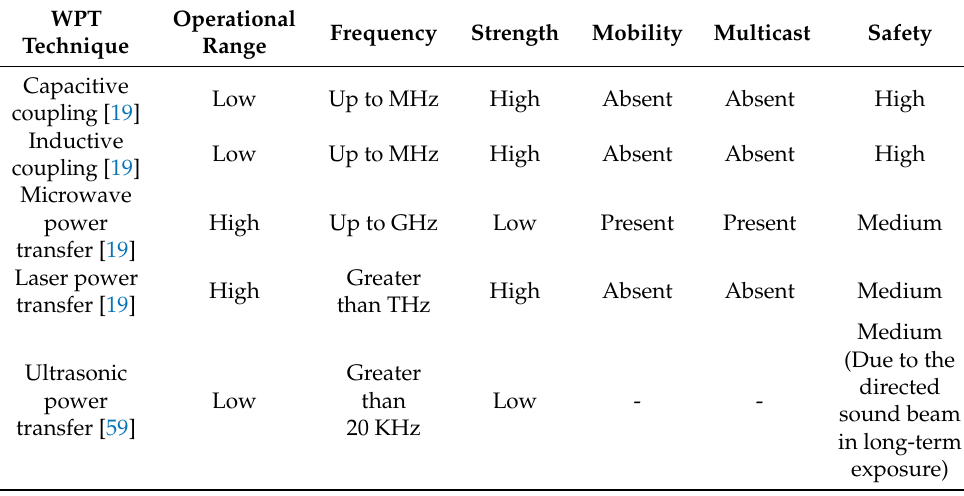
Table 3. Comparison of WPT techniques in terms of operational